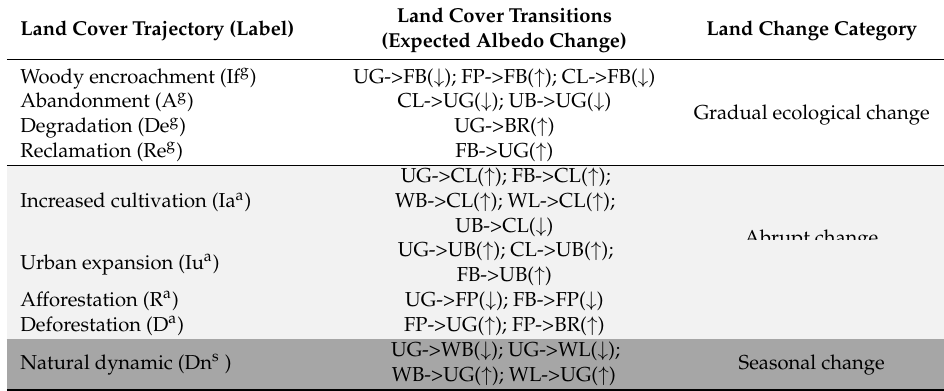
Table 1. Land cover change